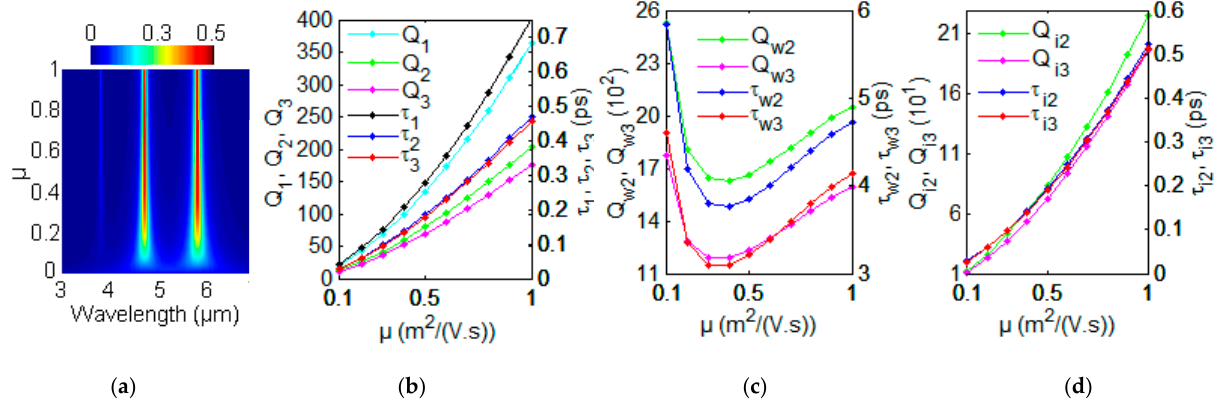
Figure 4. ( a ) The evolution of optical absorption spectra with different μ using FDTD simulation. ( b ) Q 1 , Q 2 , Q 3 and τ 1 , τ 2 , τ 3 with various μ . ( c ) Q w2 , Q w3 and τ w2 , τ w3 with various μ . ( d ) Q i2 , Q i3 and τ i2 , τ i3 with various μ .